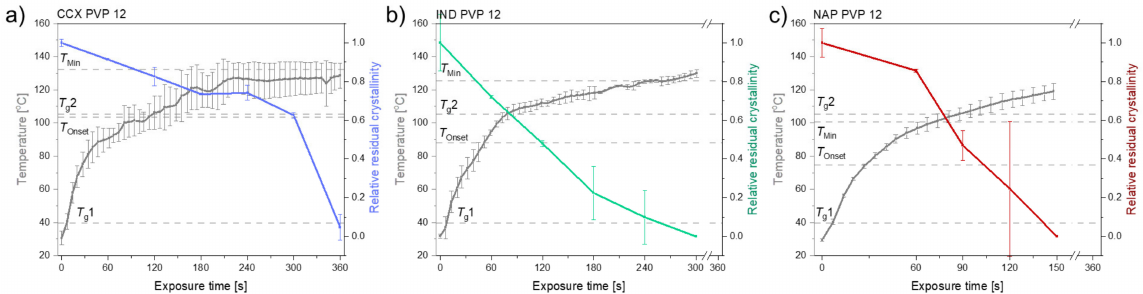
Figure 4. The temperature ( ◦ C) (left y -axis) and relative residual crystallinity (right y -axis, determined by DSC analysis) plotted as a function of exposure time [s]. All compacts were exposed at a laser intensity of 1.02 W/cm 2 . ( a ) Compacts containing CCX and PVP12 (light blue), ( b ) Compacts containing IND and PVP12 (light green), ( c ) Compacts containing NAP and PVP12 (red). Mean ± SD ( n = 3) for the left y -axis and mean ± SD ( n = 2) for the right y -axis. The horizontal dashed lines indicate the temperatures, T g 1, T g 2, T Onset and T Min , as seen in Table